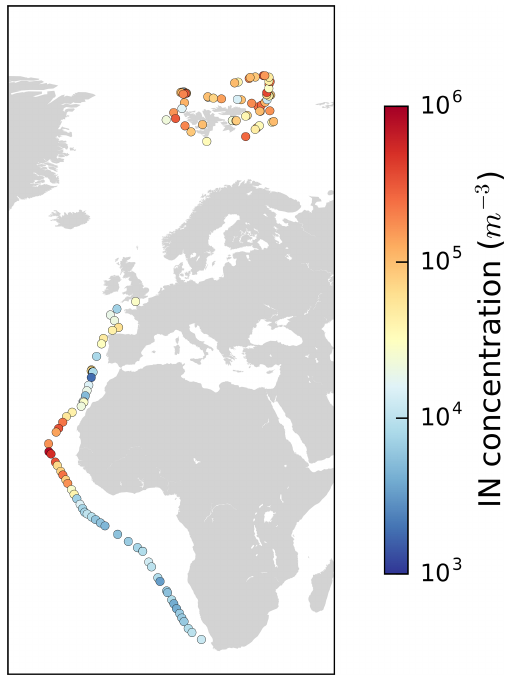
Figure 4. Map with color-coded N INP in the Arctic at − 32 ◦ C mea- sured with SPIN during PS106 and also SPIN data of a transect from Bremerhaven (Germany) to Cape Town (South Africa) along the western coast of Africa (Welti et al.,